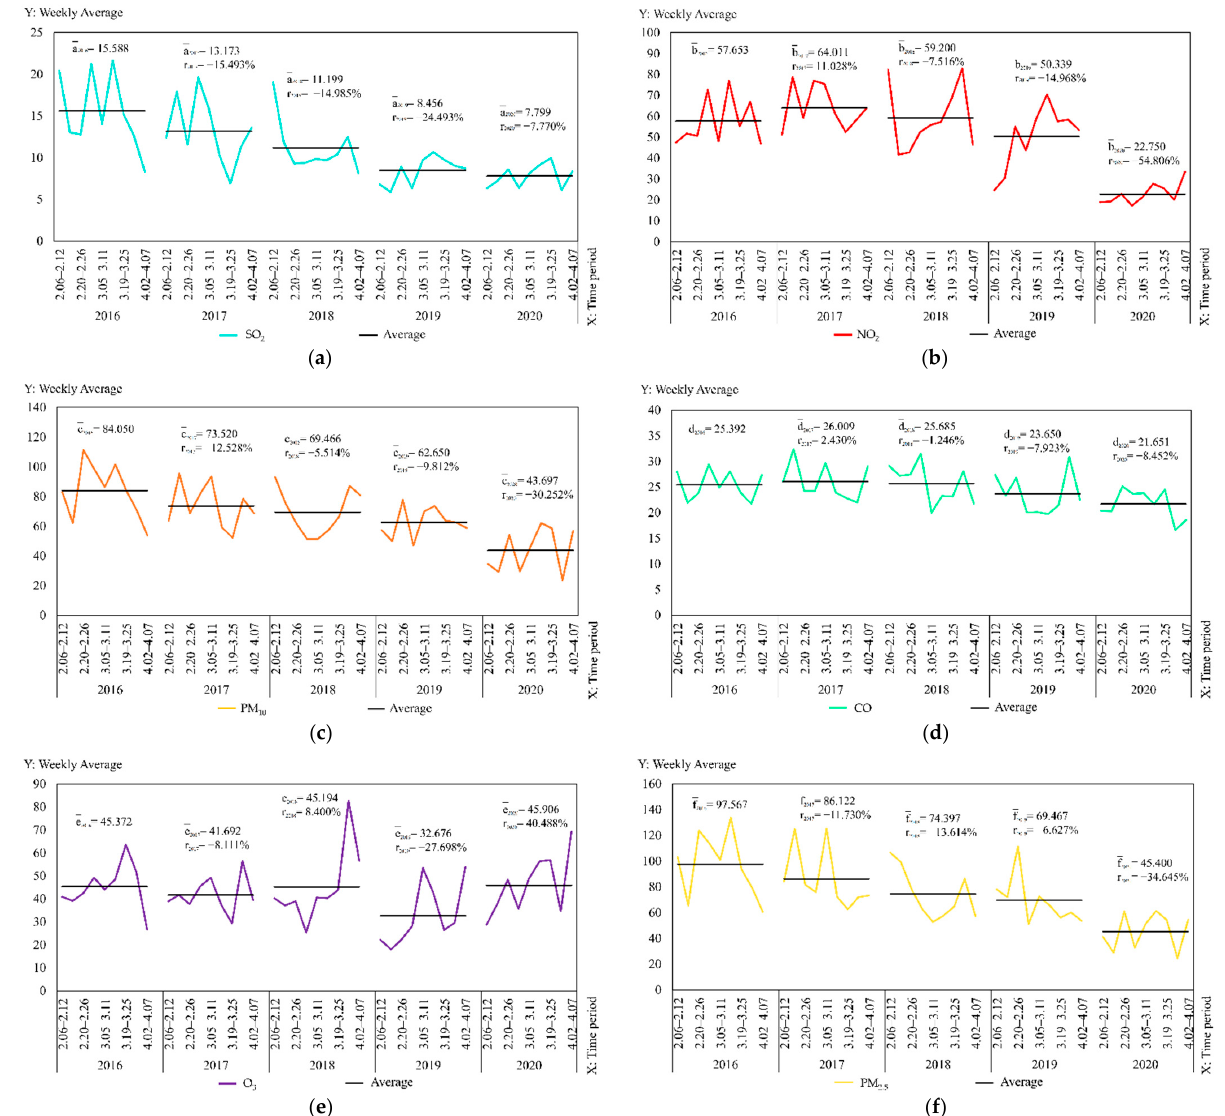
Figure 7. Weekly pollutant average year-on-year change folding chart from 2016 to 2020: ( a ) SO 2 ; ( b ) NO 2 ; ( c ) PM 10 ; ( d ) CO; ( e ) O 3 ; ( f ) PM 2.5 .